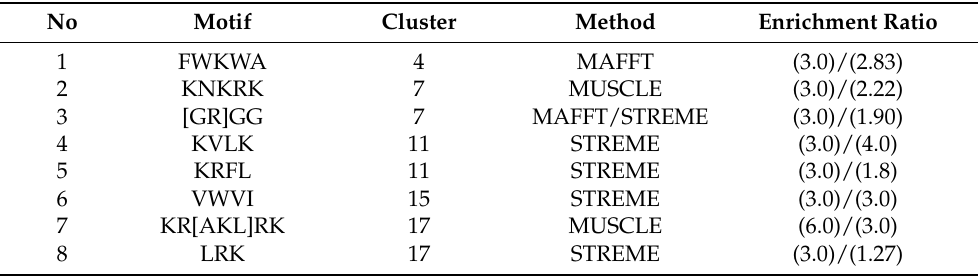
Table 7. Summary of the discovered ABFP motifs per network community (cluster), enriched in two